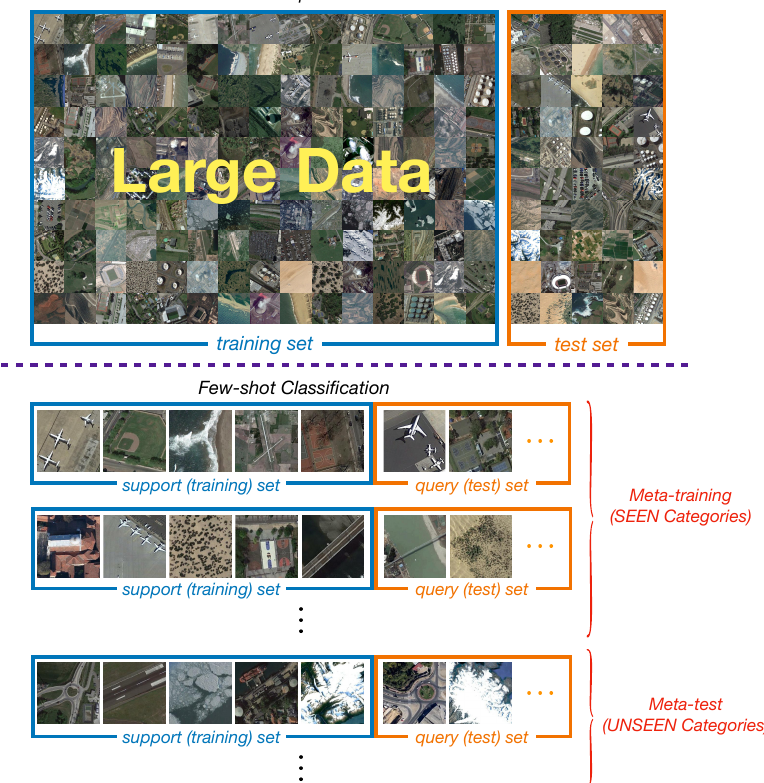
Figure 2. Comparison between the standard supervised classification and few-shot classification. The top represents the standard supervised classification mechanism in which a model is trained on a large dataset. The bottom shows a task/episode paradigm in FSL where we are dealing with the 1-shot, 5-way classification